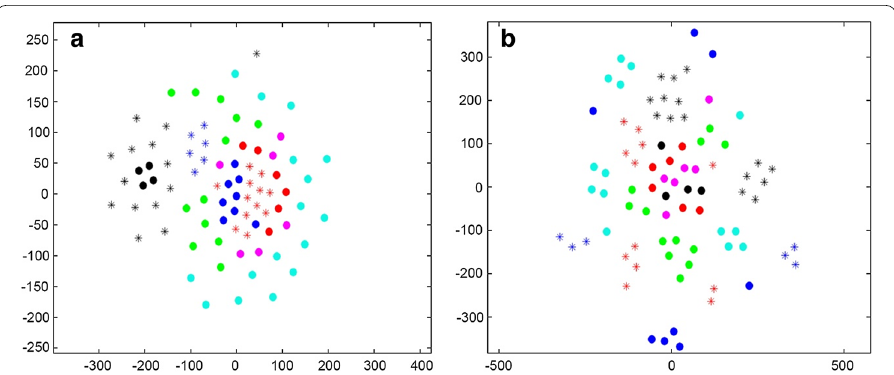
Fig. 1 a Data before batch effect correction. Data dimension has been reduced using the t-SNE algorithm so that it can be displayed properly. Each batch is illustrated in a distinct color and it is clear that each batch is grouped near each other. b Data collected from various sources after batch effect correction by the Combat software. It is clear that data related to different batches are combined and the boundaries between different batches have been